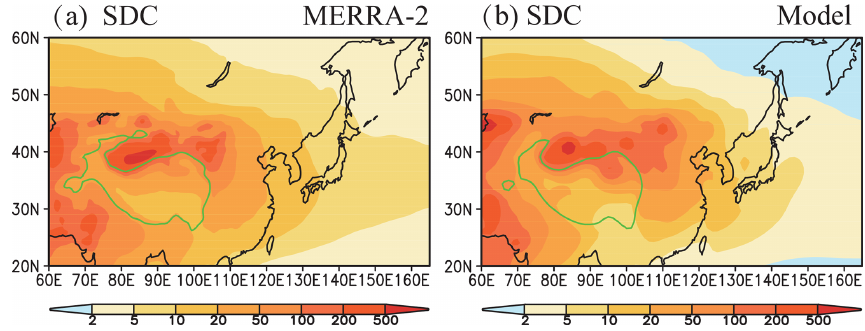
Figure 2. (a) Spatial distribution of the MAM mean surface dust concentration (SDC,µgm − 3 ) for the 30 model years and (b) for the years 1980–2008 derived from MERRA-2. The green-contour area indicates the plateau above